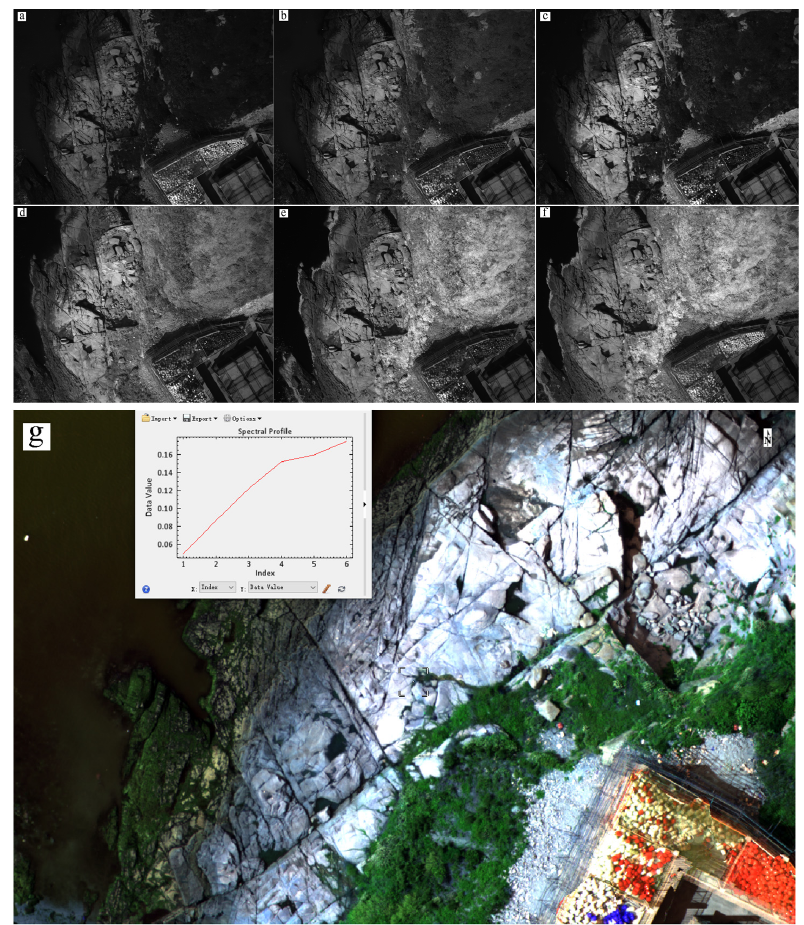
Figure 6. Raw data (6 bands) and preprocessed image (RGB display). ( a – f ) are the imaging results six bands of MS600Pro multispectral camera (bands 1–6 respectively), ( g ) is preprocessing result image displayed through RGB channels.